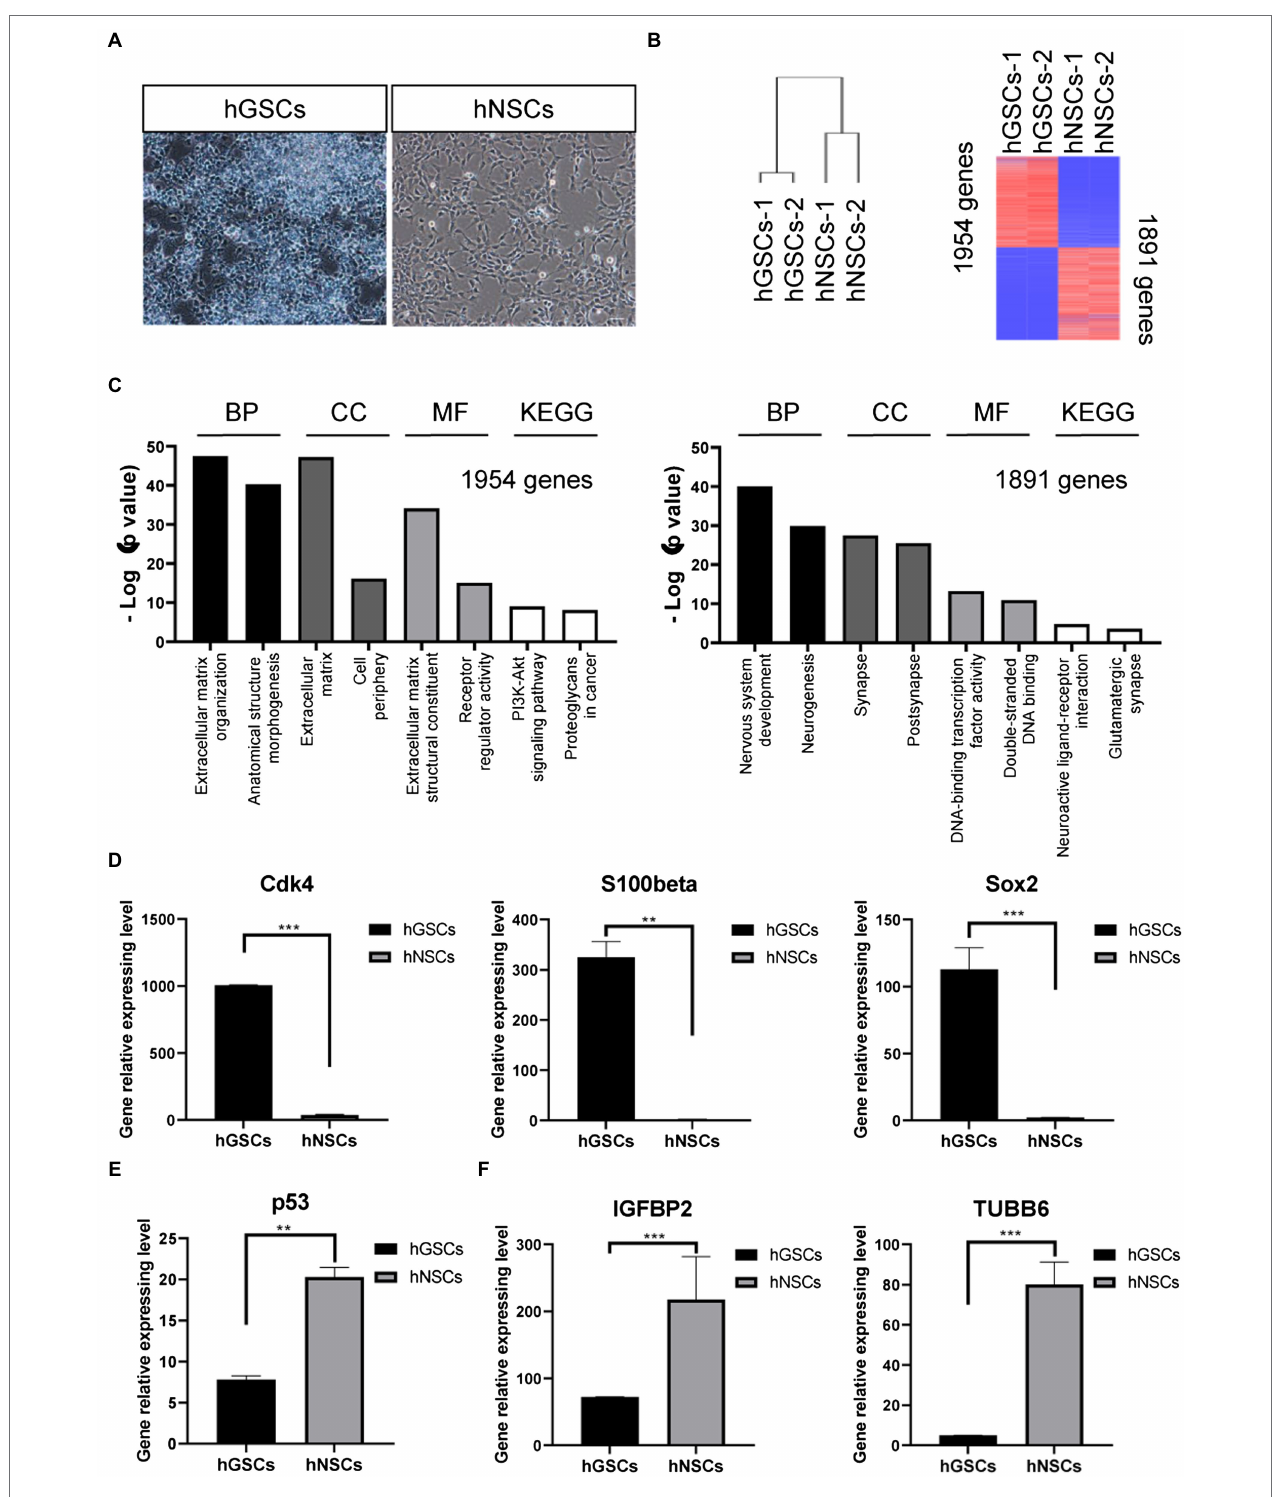
FIGURE 5 | Molecular characterization and comparison of hGSCs and human neural stem cells (hNSCs). (A) hGSCs and hNSCs were morphologically different. (B) Gene clustering analysis of hGSCs and hNSCs and differential gene expression analysis of hGSCs and hNSCs. (C) The Gene ontology analysis (biological process, cell component and molecular functions) and KEGG analysis of upregulated genes (left) and downregulated genes (right). (D) The expression of Cdk4, S100-beta, and Sox2 was higher in hGSCs than that in hNSCs. (E) The expression of tp53 was lower in hGSCs than that in hNSCs. (F) Decreased IGFBP2 and TUBB6 expression was observed in hGSCs, compared to hNSCs. Data are represented as mean ± SD with n = 3 biological